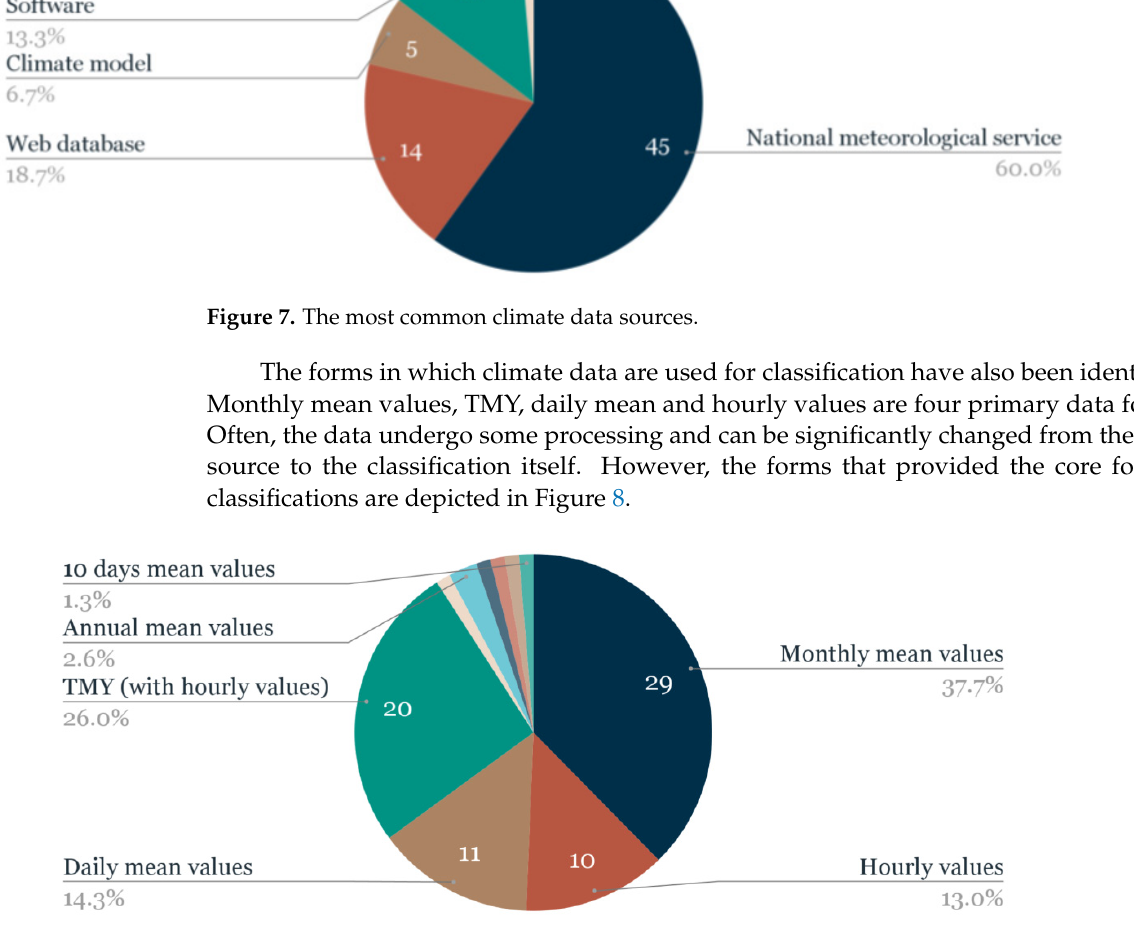
Figure 8. The most prevalent forms of climatic data used to develop the classifications.